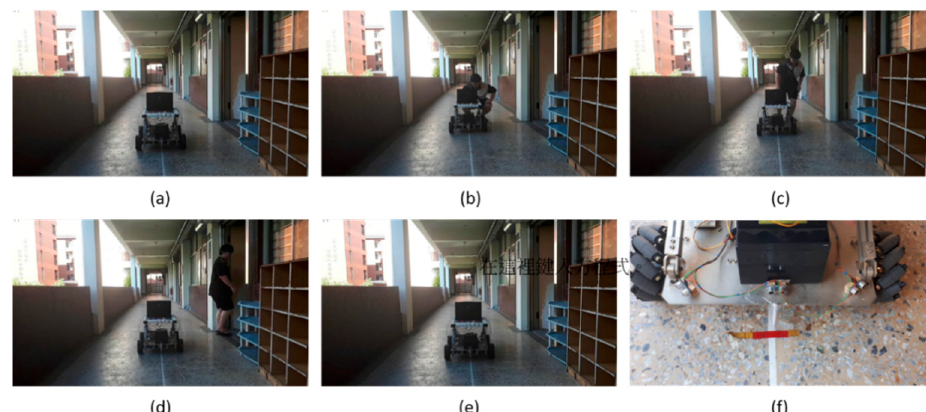
Figure 13. Omnidirectional Mecanum-wheeled automated guided vehicle (OMWAGV) walking straight 100 cm without